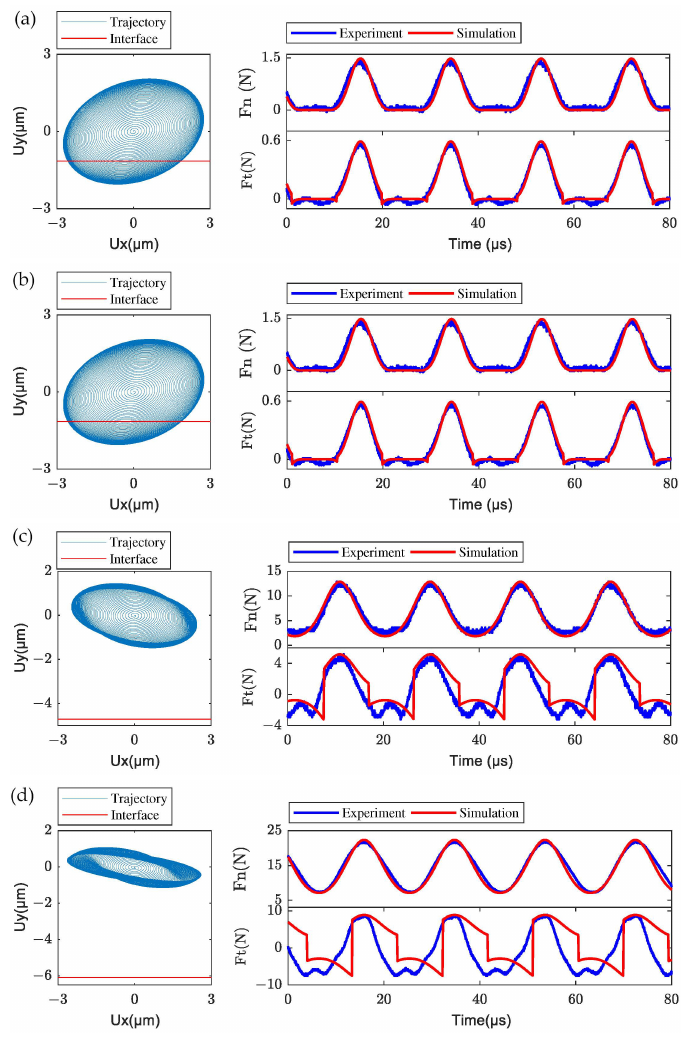
Figure 19. Transient nodal trajectory at the center of the contact tip and the comparison of frictional contact forces between experiments and simulations for different pre-pressures: ( a ) 0 N, ( b ) 1 N, ( c ) 10 N, and ( d ) 20